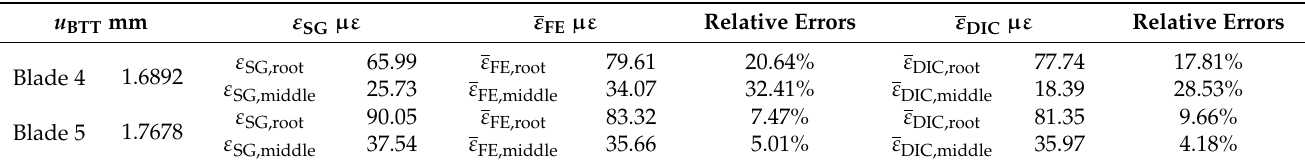
Table 3. Dynamic strains from SG and predicting model in blade synchronous vibration of 3 EO.